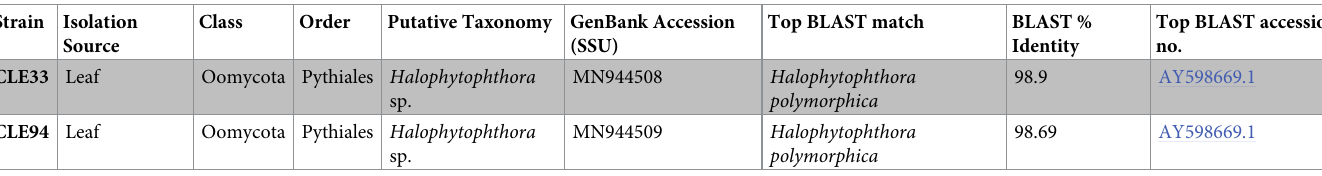
Table 3. Oomycota isolated from the seagrass, Zostera marina